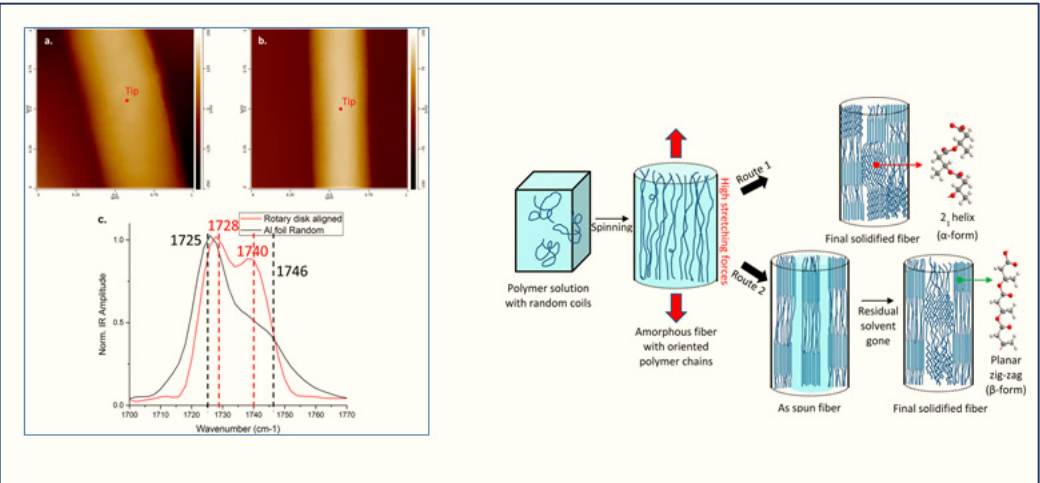
Figure 11. AFM-IR images and possible mechanisms for the formation of the α - and β -form crystal structure of single electrospun of PHBHx nanofibers. Reproduced with copyright permission from Gong 2015 [56] (American Chemical Society).